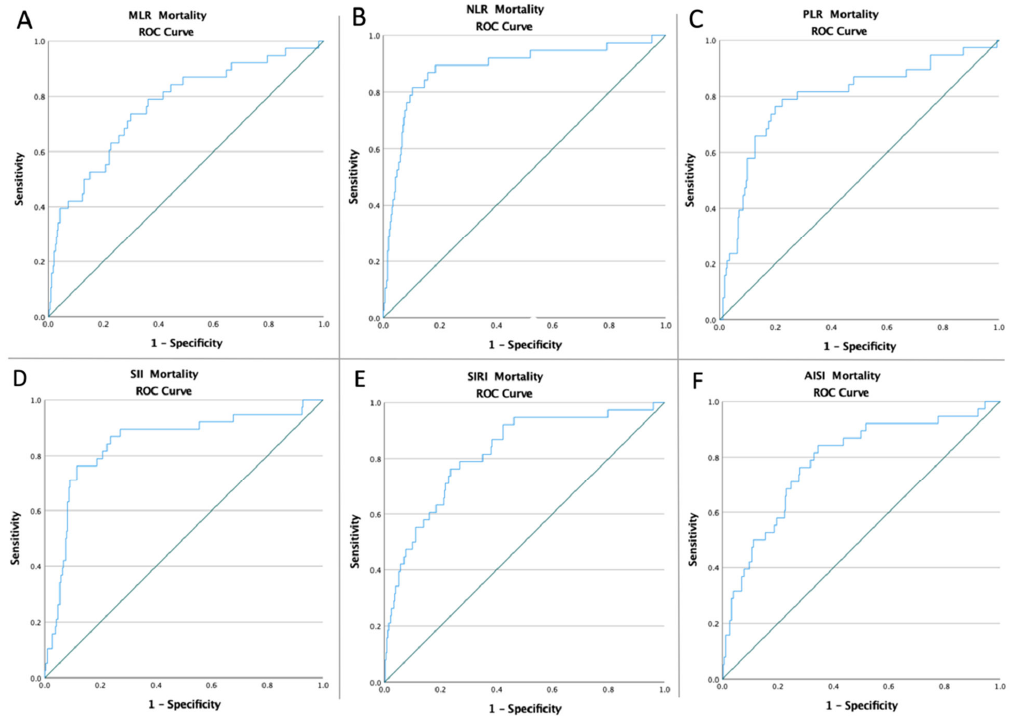
Figure 2. ROC curve analysis concerning Mortality ( A ) for the MLR (AUC: 0.765; p < 0.0001), ( B ) for the NLR (AUC: 0.885; p < 0.0001), ( C ) for the PLR (AUC: 0.794; p < 0.0001), ( D ) for the SII (AUC: 0.844; p < 0.0001), ( E ) for the SIRI (AUC: 0.819; p < 0.0001), and ( F ) for the AISI (AUC: 0.784; p < 0.0001). Table 2. The AUC of the ROC curve, 95% confidence interval, sensitivity, and specificity of the pre- operative inflammatory markers. Variables Cut-Off AUC Std. Error